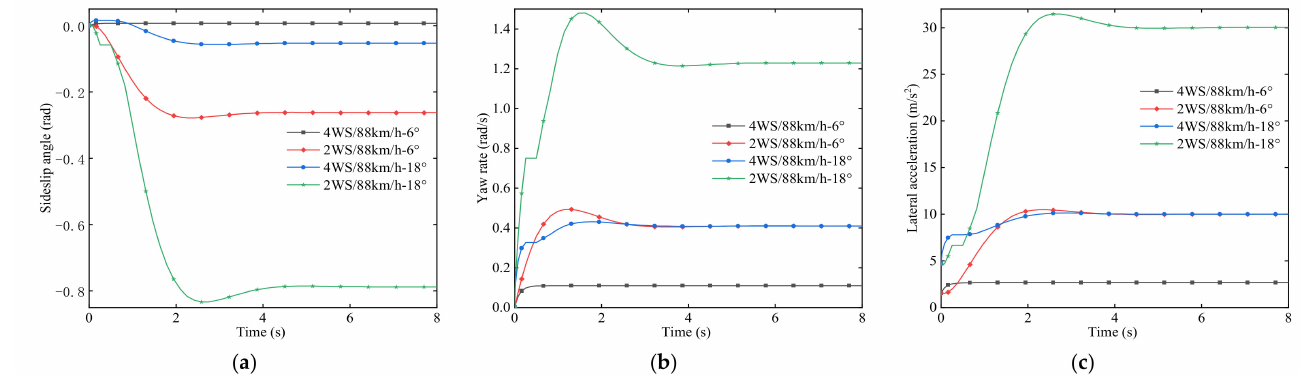
Figure 15. Simulation comparison of different rotation angles at high speed. ( a ) Sideslip angle.